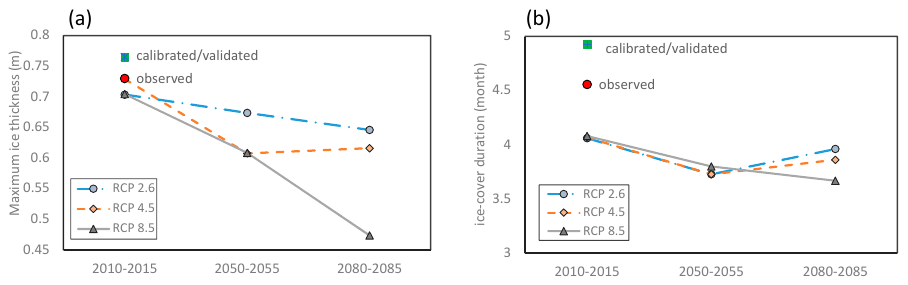
Figure 6. Climate change impact on ( a ) maximum ice thickness and ( b ) ice-on duration.